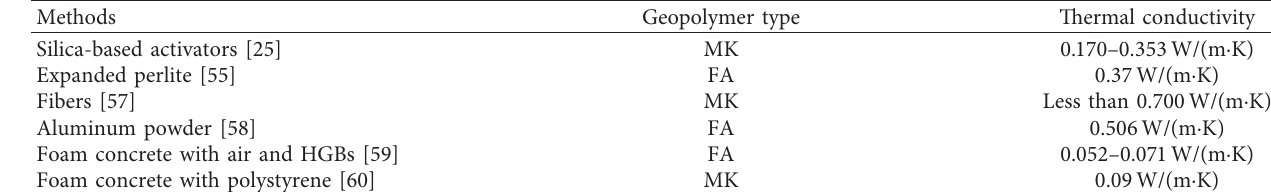
Table 2: Effects of different measures on thermal insulation